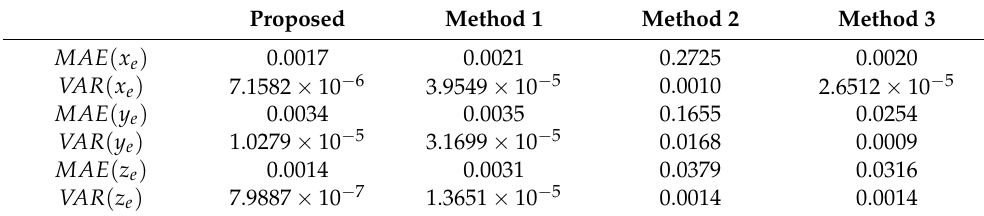
Table 8. Data analysis of steady-state for Case 2 (from 50 s to 300